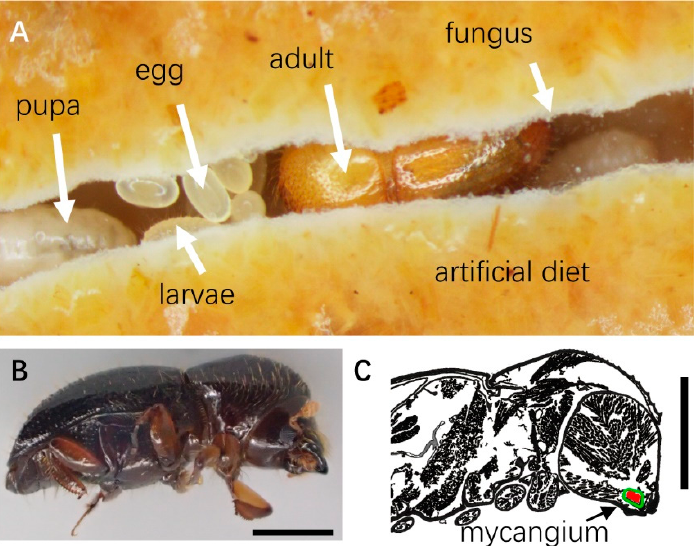
Figure 1. Typical reproduction of an ambrosia beetle, Euwallacea interjectus , on a semi-artificial diet. ( A ) Progeny (egg, larva, pupa, and new adult) in a gallery that the dispersed female adult (their mother) oviposited after the establishment of ambrosia fungi in the diet. ( B ) Female adult of E. interjectus in lateral views which emerged on the diet. ( C ) Micro-CT scanning cross-section of oral mycangium (colored in green) in the female adult by Jiang et al. [33] (unpublished image): in its dispersal period, the mycangium has filled with compacted fungal inoculum (colored in red), which is used to propagate a fungal garden in newly-bored galleries. Scale = 1 mm.